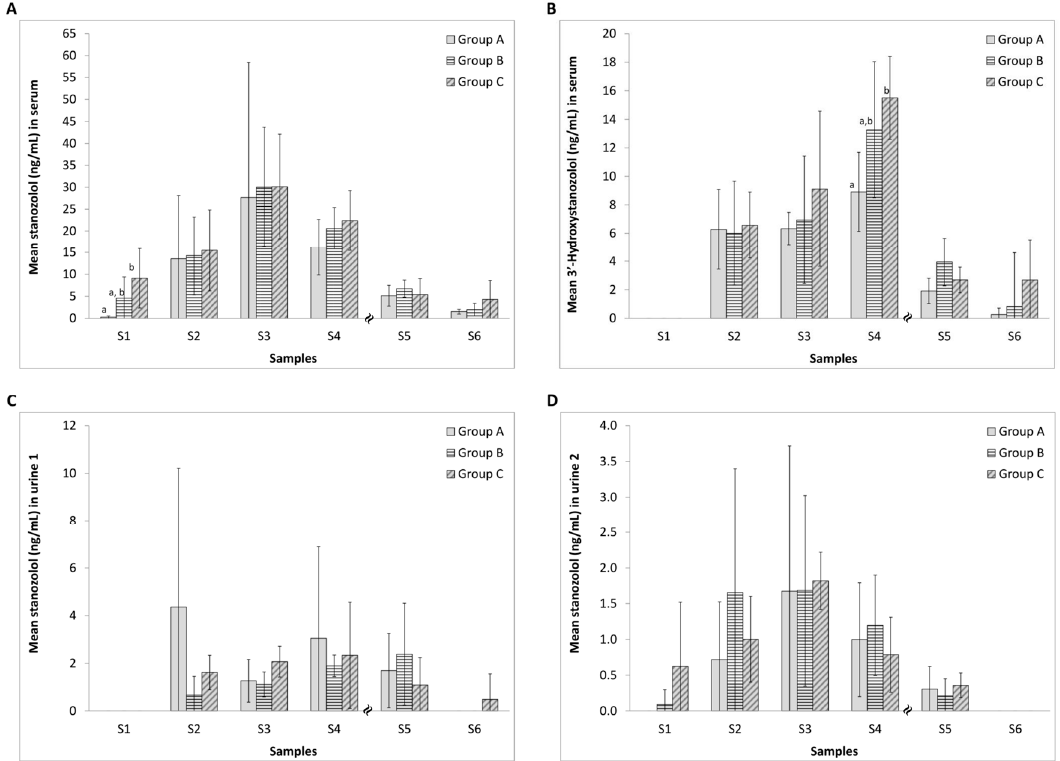
Figure 2. Concentrations of stanozolol and 3 ′ -hydroxystanozolol in serum (( A , B ) respectively) and stanozolol in urine samples (( C ) pre-treatment (urine 1) and ( D ) one hour post-treatment (urine 2)) from group A (5 mg/kg stanozolol only), group B (5 mg/kg stanozolol + 1 mg/kg diclofenac) and group C (5 mg/kg stanozolol + 5 mg/kg diclofenac). Error bars represent standard deviations. Different letters (A,B) denote statistically significant differences between the treatment groups ( p < 0.05) at a sampling point. Effect sizes are given in Table S1. Test sensitivity over time differences, are displayed in Table S2.